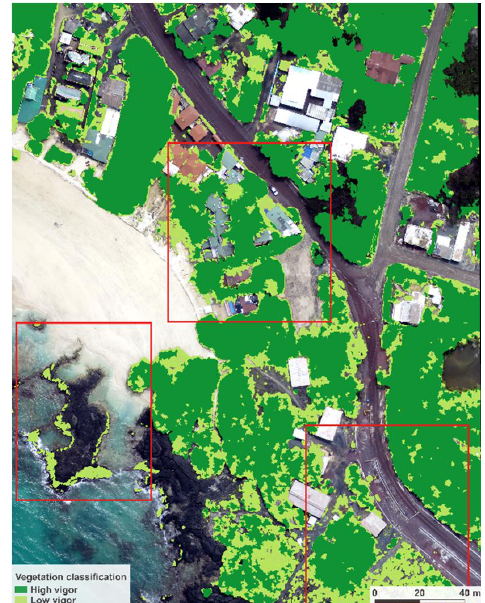
Figure 9. Classification of region of interest. Red squares are details shown by figure